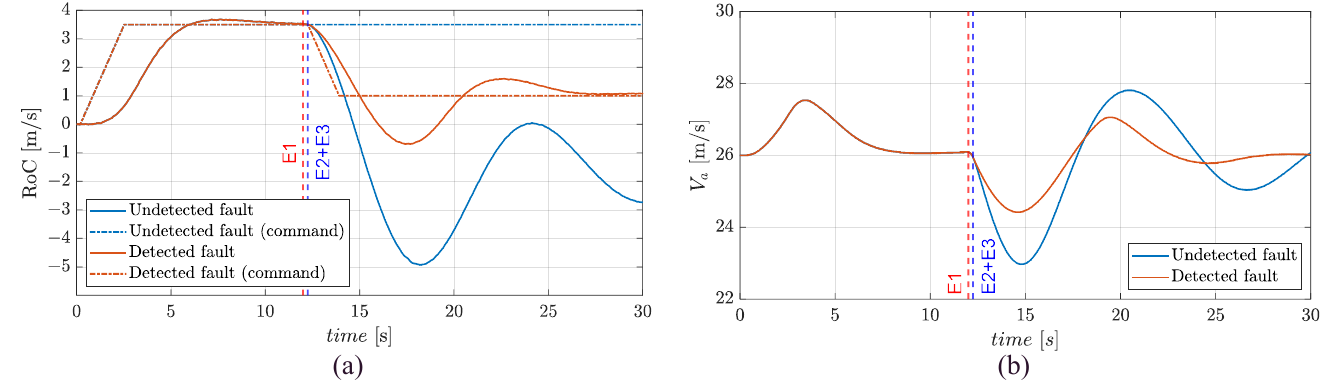
Figure 9. UAV response in climb with phase-to-ground fault on stator 2 (E1, E2 and E3 defined in Section 3.1): RoC ( a ), airspeed ( b ).